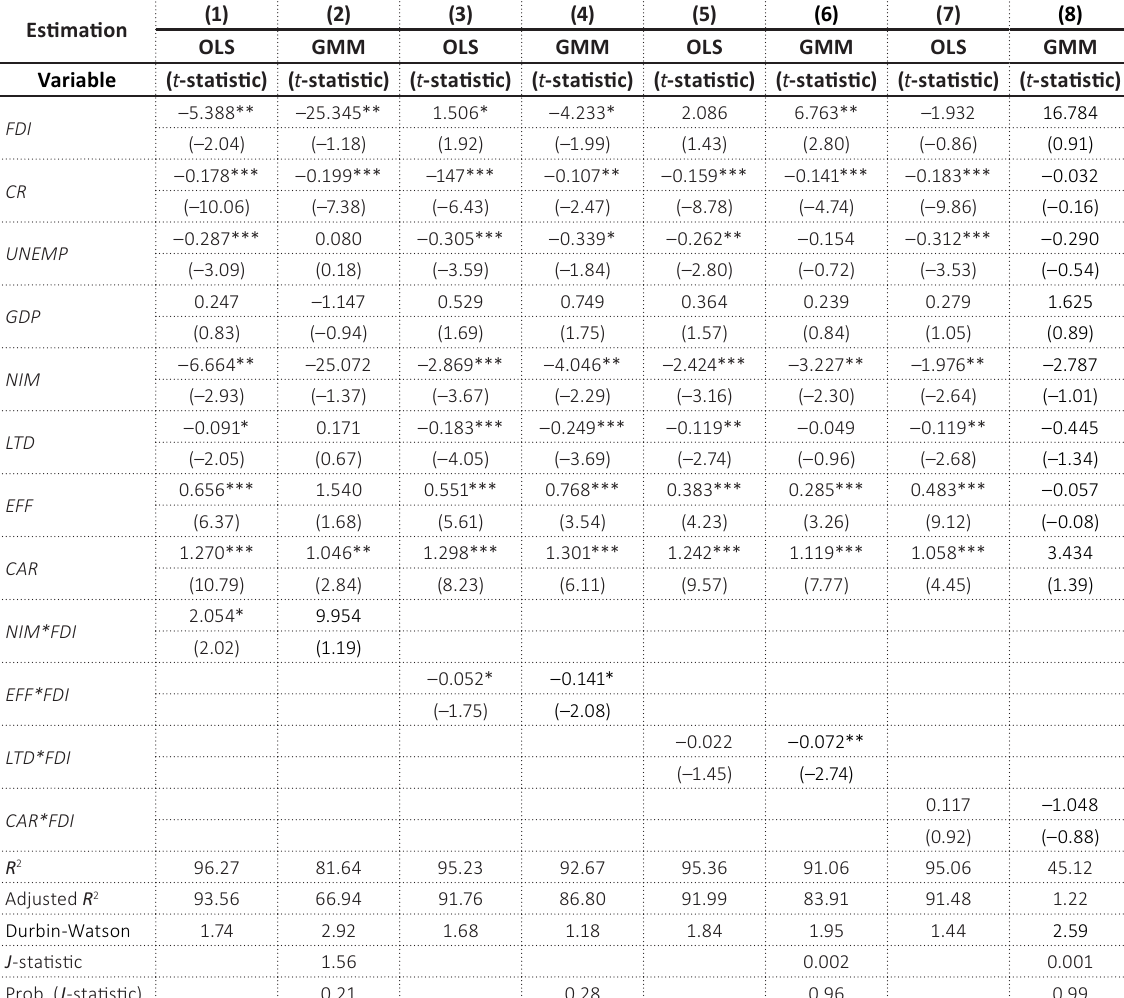
Table 7. Joint-effect of FDI inflows and banking sector characteristics on NPLs